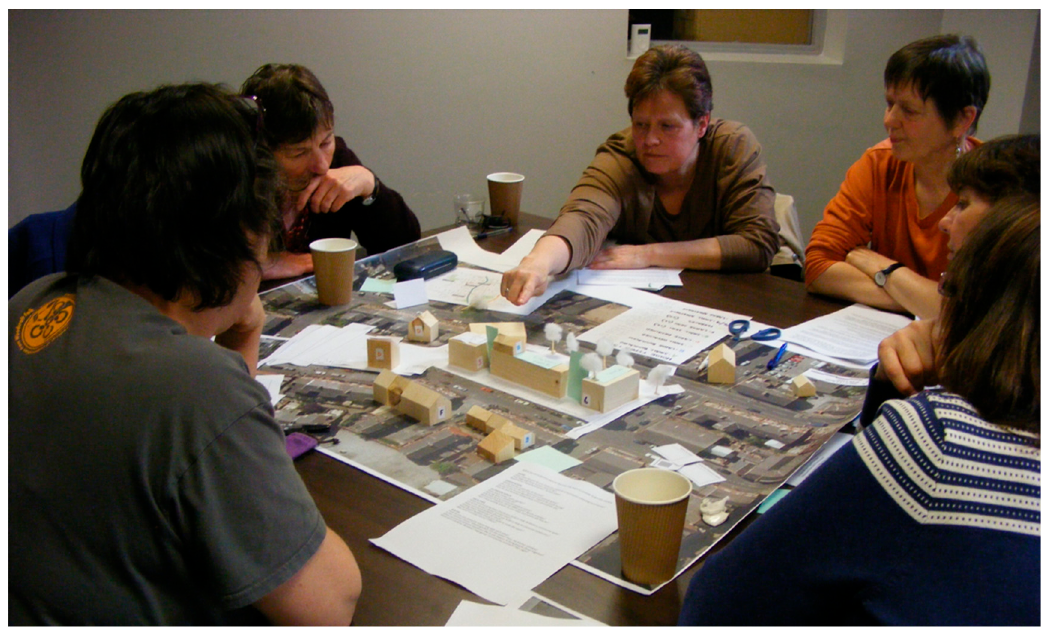
Figure 1. Manchester Urban Cohousing (MUCH) members participating in the design game workshop.